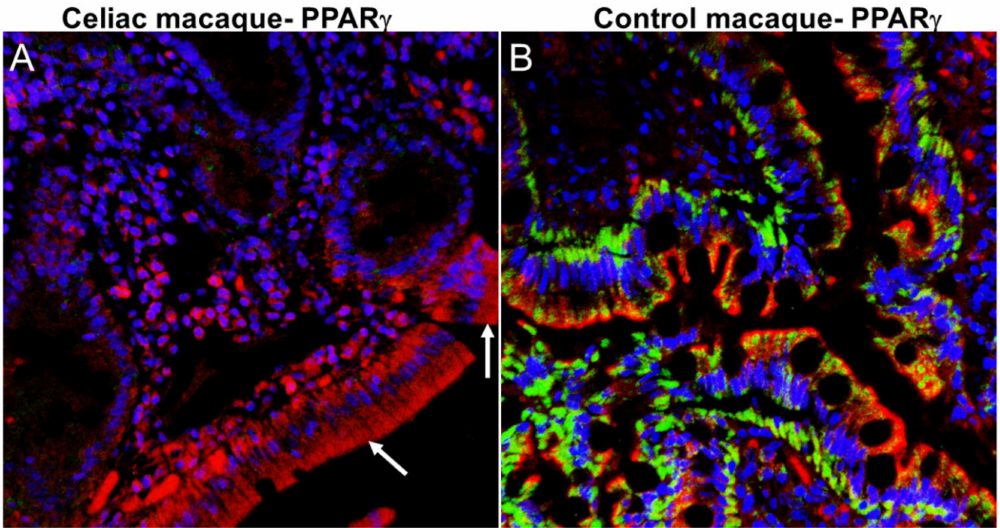
Figure 3. Peroxisome proliferator activator receptor gamma ( PPAR γ ) protein expression is significantly decreased in DE of celiac macaques. All panels involve triple labels with PPAR γ ( green ), cytokeratin ( red ) and Topro3 for nuclear staining ( blue ). Colocalization appears yellow. Note the marked loss PPAR γ ( A ) (white arrow) staining in the DE of the celiac macaque. In contrast, PPAR γ protein ( B ) staining is intense in the DE of the control macaque. Magnification for both panels is 40 × . PPAR γ (Cat#LS-B651-50) antibody that cross reacts with the rhesus macaque was purchased from Lifespan Biosciences, Seattle, WA,